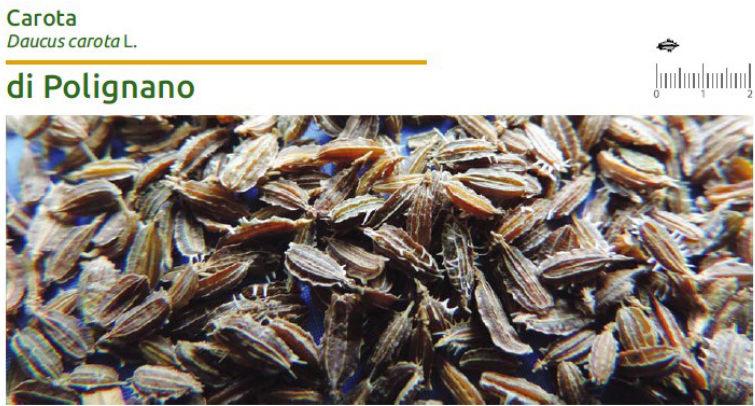
Figure 15. Seeds of Polignano carrot with indication of size (Photo credit: Beniamino Leoni).